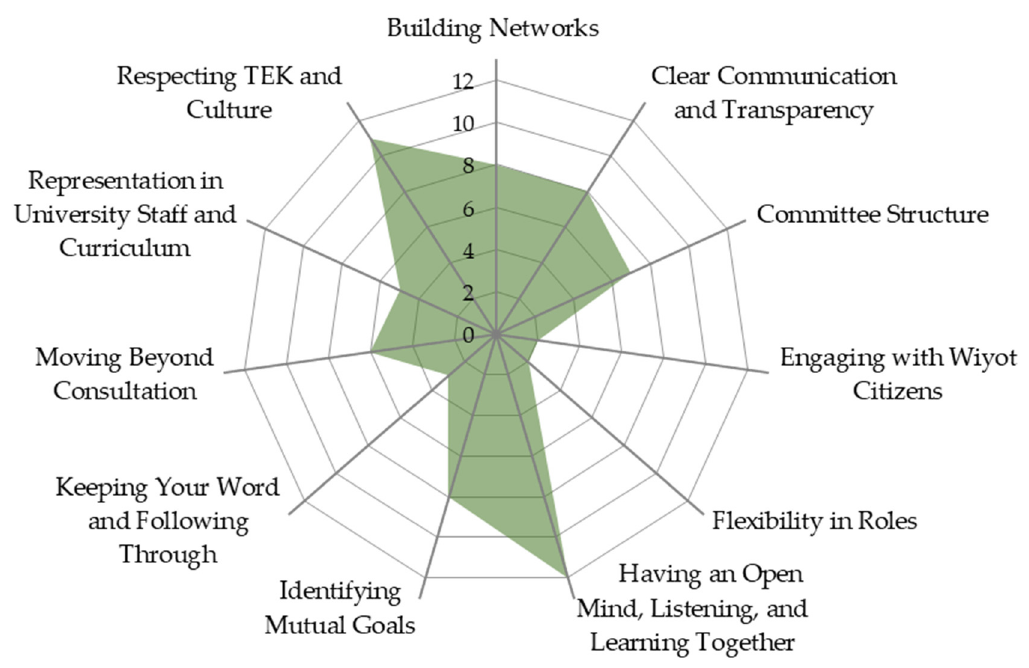
Figure 3. The frequency of participants that spoke about subthemes relating to co-management. For example, 8 out of 13 total participants spoke about the co-management subtheme ‘building